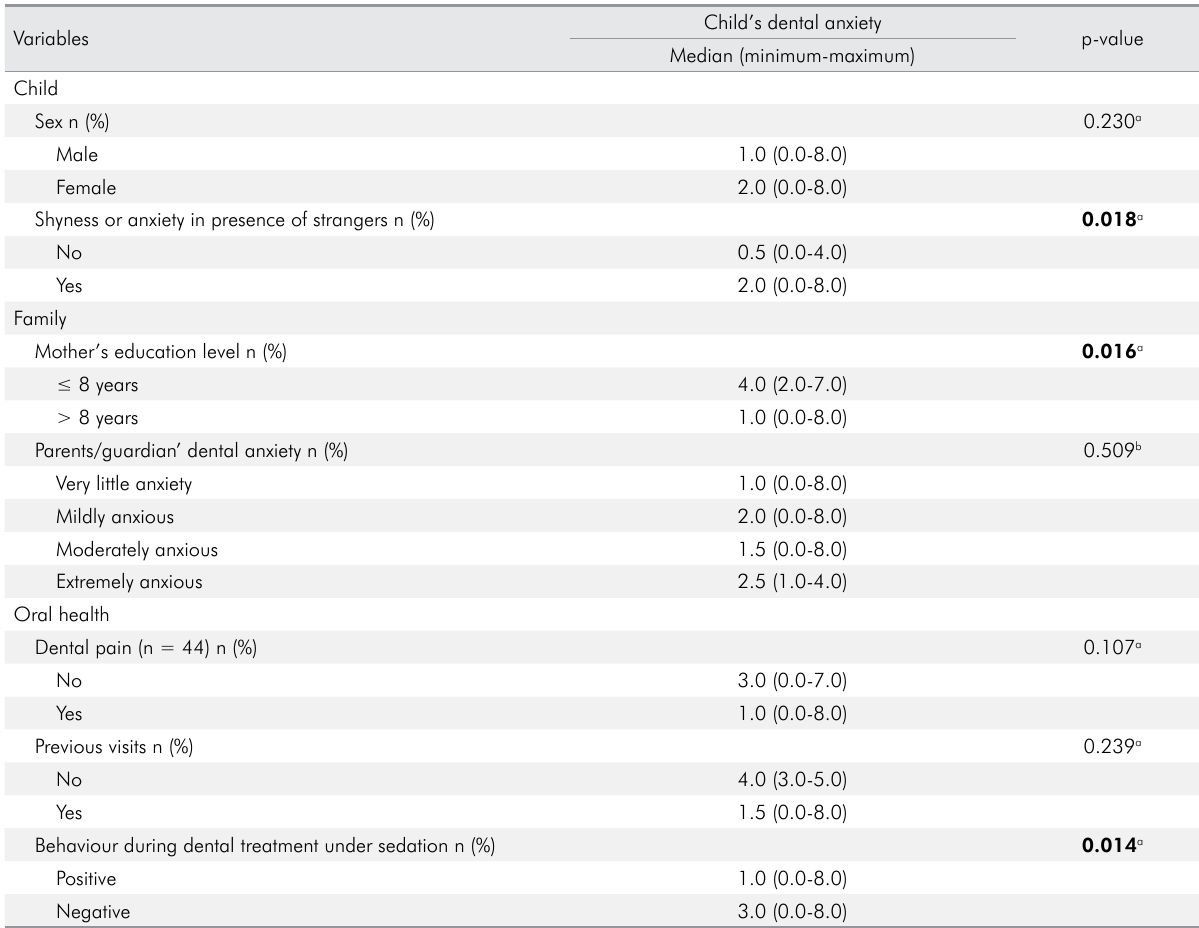
Table 2. Comparison punctuation of VPT among categories of independent